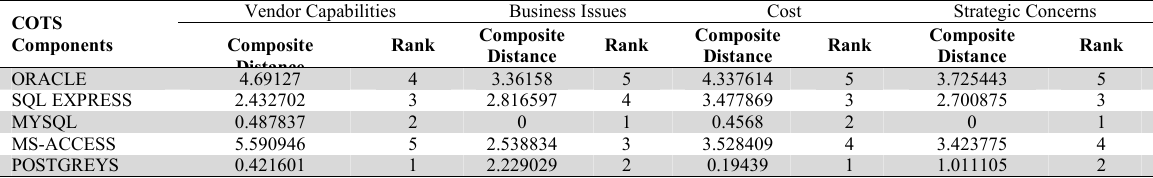
Overall Ranking of DBMS COTS Component using DBA Vendor COTS Components